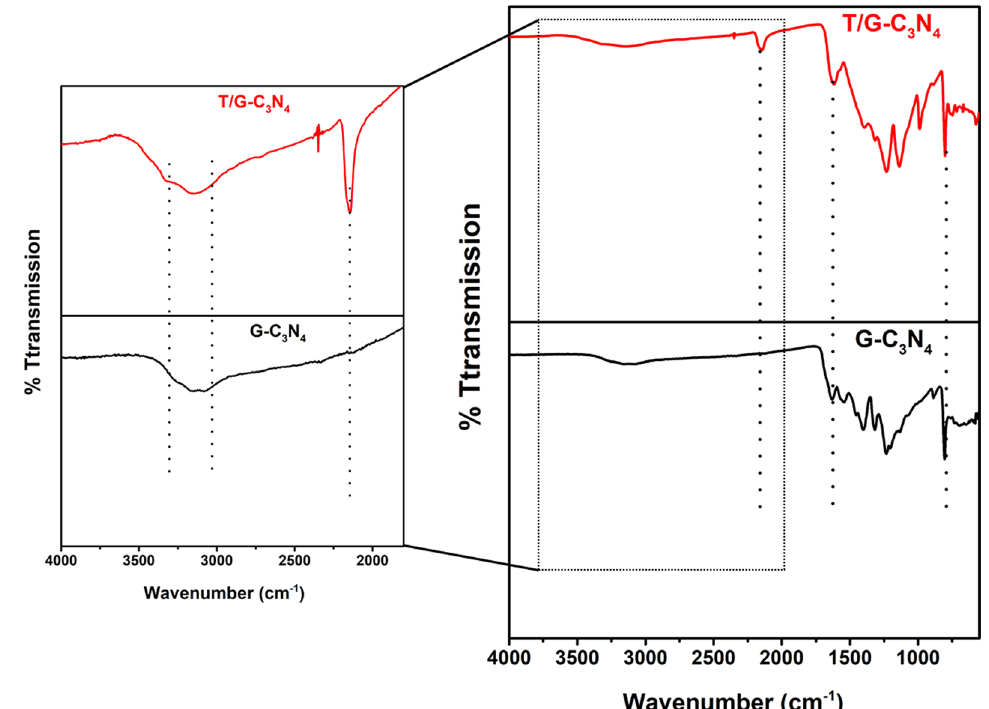
Fig. 2 FTIR spectra of G‑C 3 N 4 , and T/G‑C 3 N 4